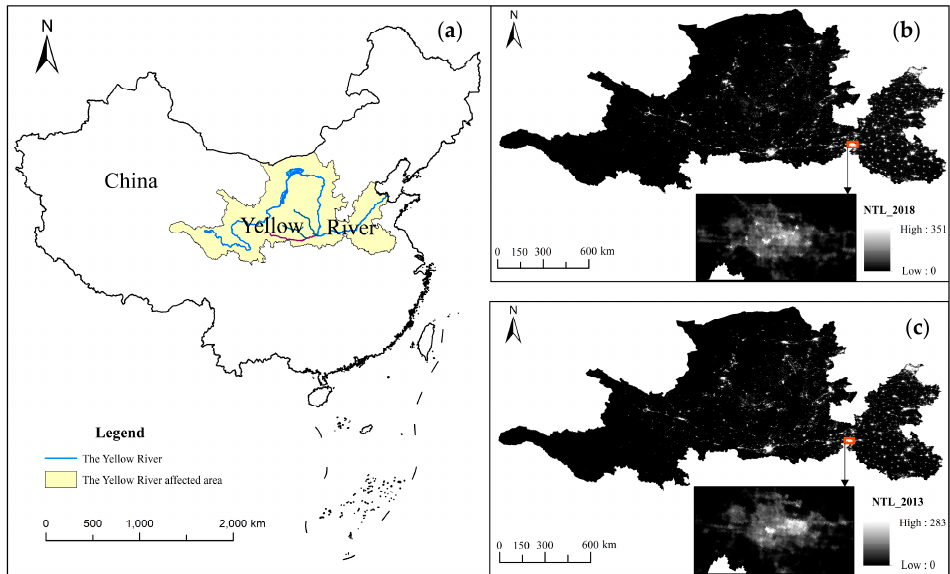
Figure 1. ( a ) The location of the Yellow River affected area and an overview of the study area; ( b ) Night light data of the Yellow River affected area in 2018; ( c ) Night light data of the Yellow River affected area in 2013.